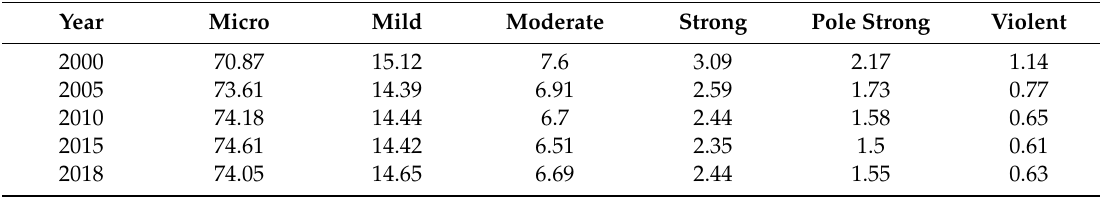
Table 4. Proportion of di ff erent soil erosion intensity grades in the Taohe River Basin in 2000, 2005, 2010, 2015 and 2018